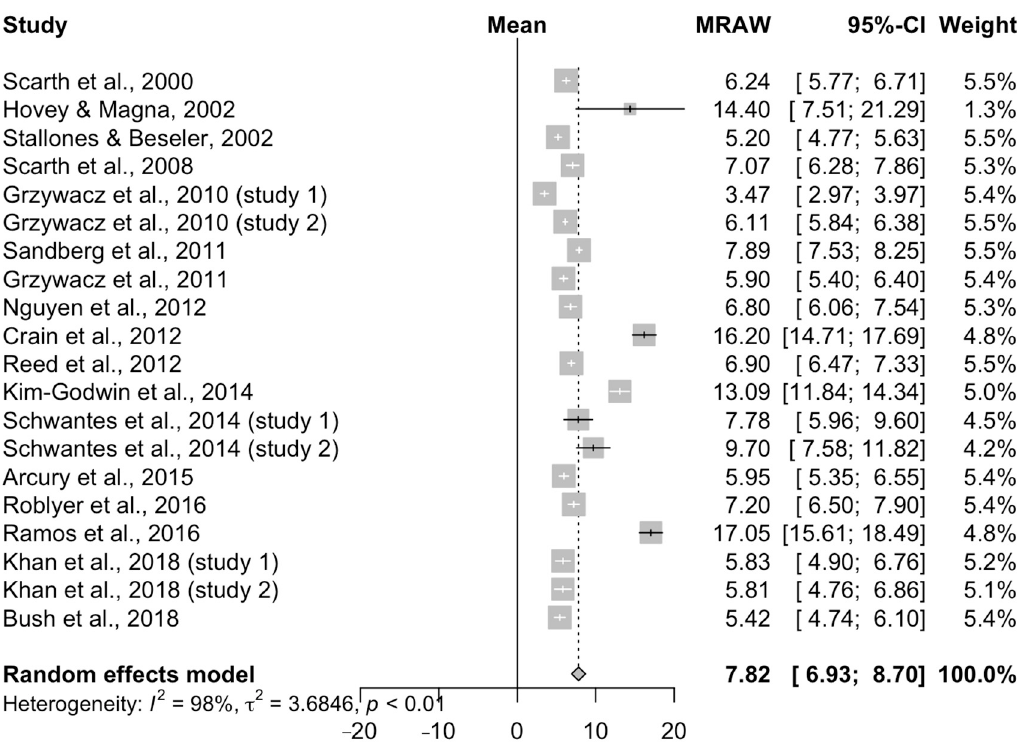
Figure 3. Overall meta-analysis for the 20 studies conducted in the United States reporting a continuous outcome (raw mean score, MRAW) using the CES-D / DR scale to measure depression in farming populations.